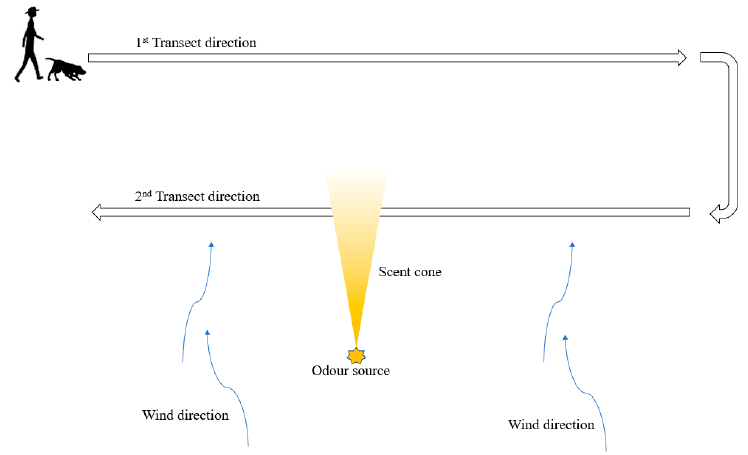
Figure 2. Second stage of transect search training designed to help increase search scale and search stamina. Here teams begin downwind from the target odor and commence an initial transect outside of a scent cone before progressing through it on subsequent transects.